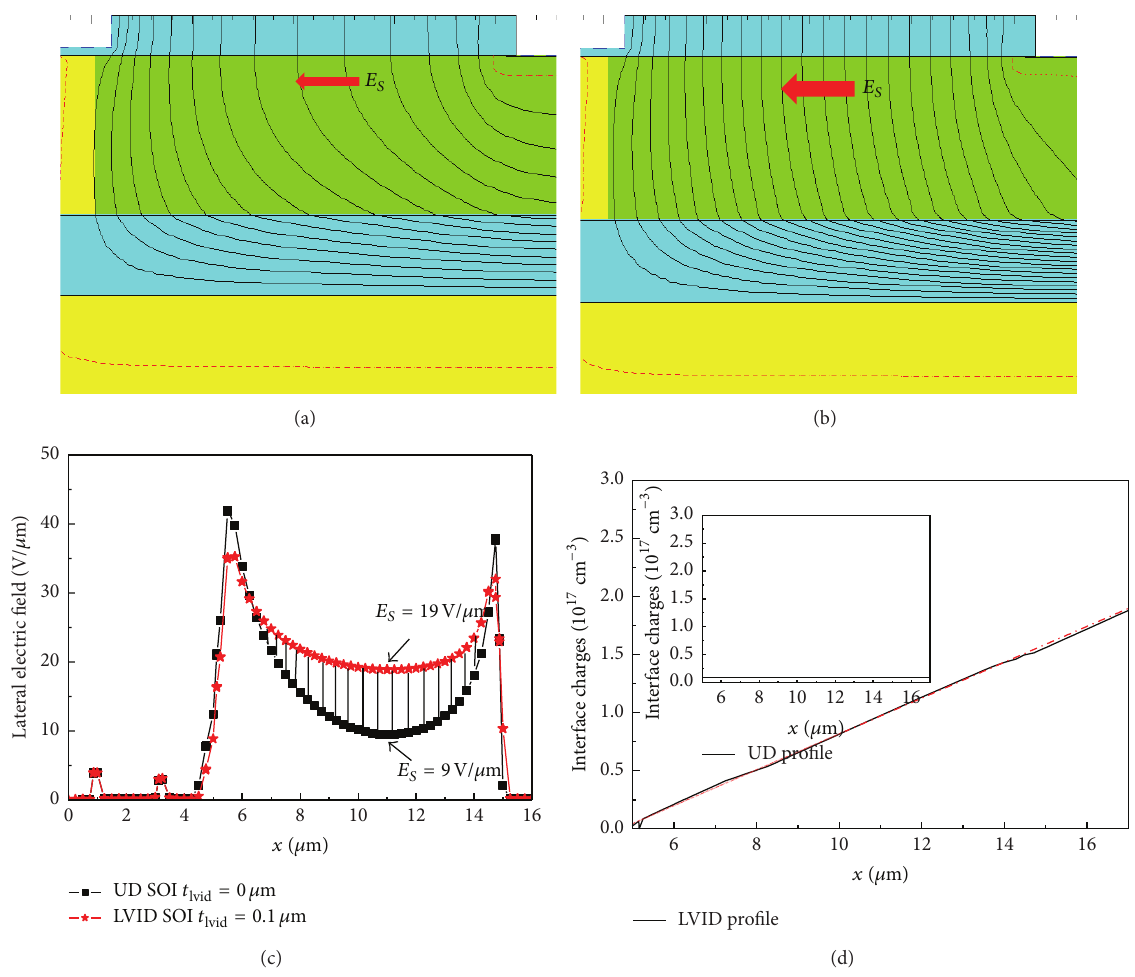
Figure 3: Distributions of equipotential contours, electric fields, and interface charges at breakdown for the UD and LVID SOI LDMOS. (a) Equipotentialcontours(10V/contour)distributionsfortheUDSOILDMOSwiththeoptimized 𝑁 𝑑 =9 × 10 15 cm −3 ;(b)equipotentialcontours (10V/contour) distributions for the LVID SOI LDMOS with the optimized 𝑁 𝑑 = 4 × 10 15 cm −3 , 𝐺 = 4.48 × 10 20 cm −4 . (c) The comparison of the lateral surface electric field distributions at breakdown. (d) Interface charges concentration distributions of LVID profile and UD profile at